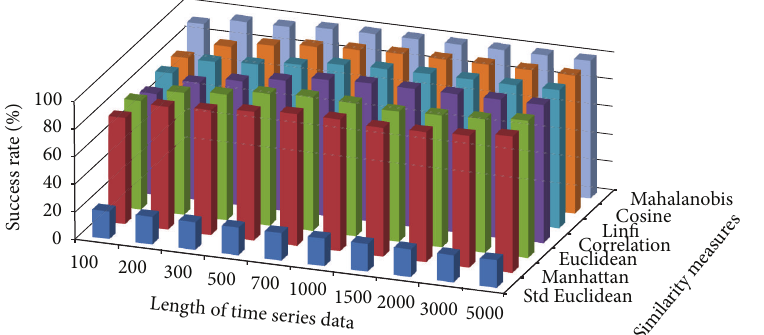
Figure 4: Average success rate of pattern recognition with different similarity measures and the length of time series in first scenario.